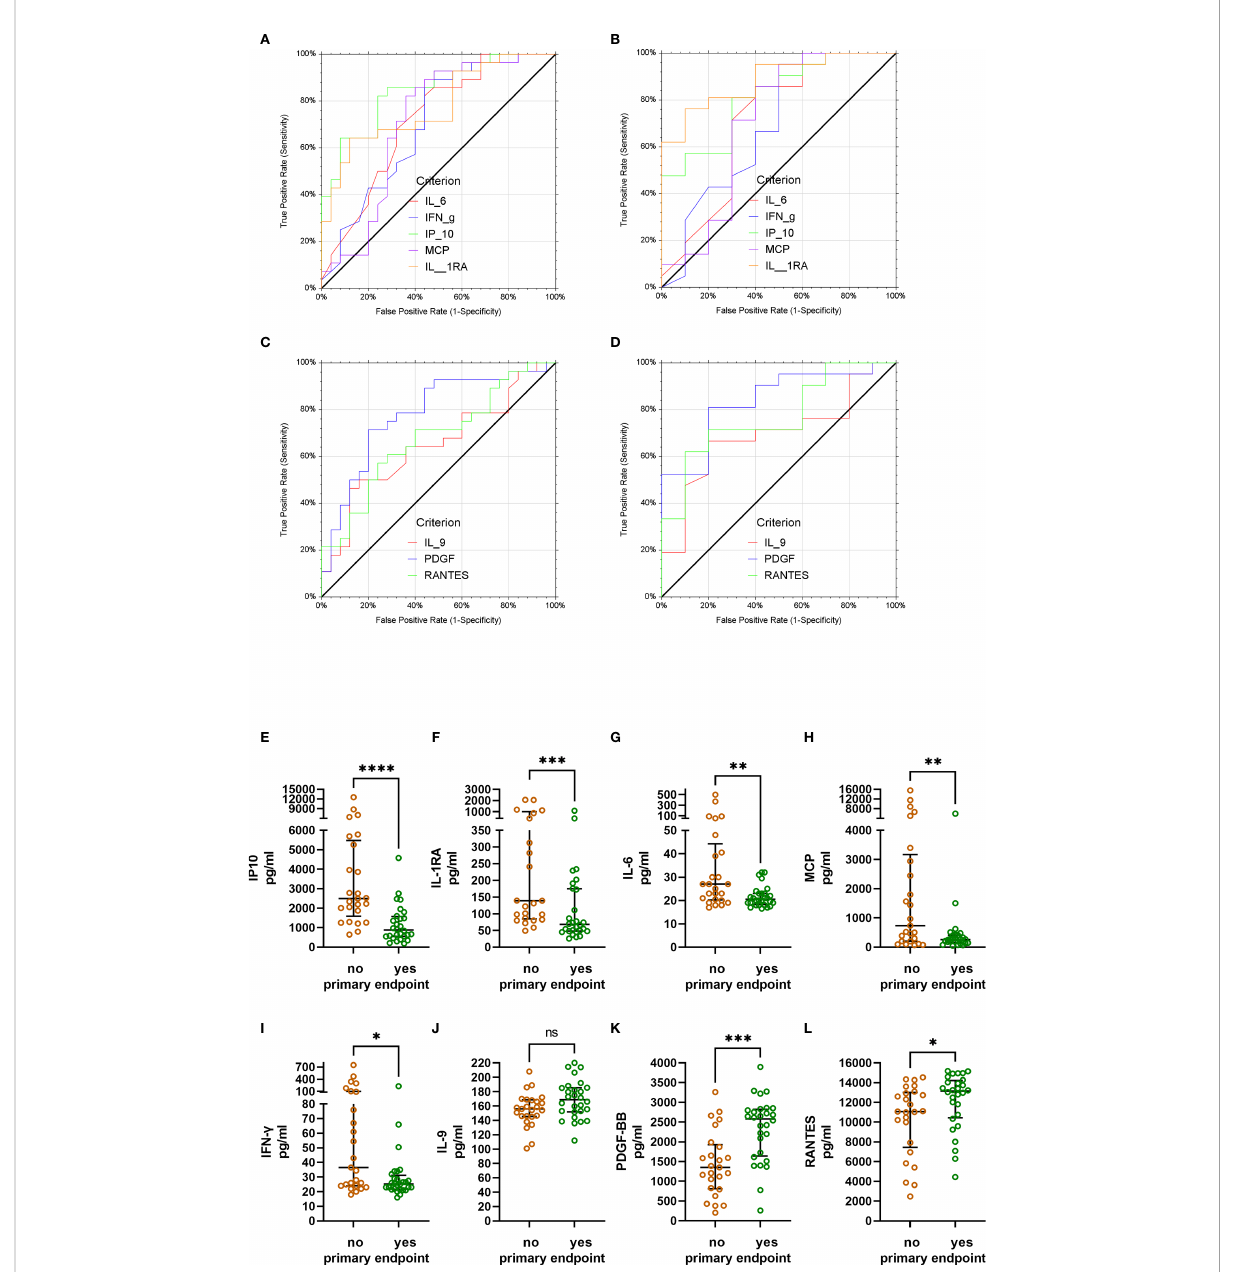
FIGURE 6 Receiver operating characteristics analysis of day 7 cytokine levels and primary endpoint (failure vs. success on day 21). (A) All patients (irrespective of allocation to randomization group). Low levels of IP-10, IL-1RA, MCP-1, IL-6 and IFN- g on day 7 indicate treatment success. Area under the curve (AUC) and p-values for AUC >0.5 were as follows: IP-10: AUC 0.85; p<0.0001; IL-1RA: AUC 0.78, p<0.0001; IL-6: AUC 0.72, p=0.0012; MCP-1: AUC 0.71, p=0.0033; IFN- g : AUC 0.70, p=0.0038). (B) Patients in the CCP group. Low levels of IP-10, IL-1RA, MCP-1 and IL-6 on day 7 indicate treatment success. AUC and p-values for AUC >0.5 were as follows: IP-10: AUC 0.82; p<0.0001; IL-1RA: AUC 0.89, p<0.0001; IL-6: AUC 0.71, p=0.0345; MCP-1: AUC 0.70, p=0.0499; IFN- g : AUC 0.69, p=0.0516). (C) All patients (irrespective of allocation to randomization group). High levels of PDGF-BB, RANTES and IL-9 on day 7 indicate treatment success. AUC and p-values for AUC >0.5 were as follows: PDGF- BB: AUC 0.78; p<0.0001; RANTES: AUC 0.68, p=0.0080; IL-9: AUC 0.65, p=0.0260). (D) Patients in the CCP group. High levels of PDGF-BB, RANTES and IL-9 on day 7 indicate treatment success. AUC and p-values for AUC >0.5 were as follows: PDGF-BB: AUC 0.84; p<0.0001; RANTES: AUC 0.77, p=0.0012; IL-9: AUC 0.69, p=0.0279). (E-L) Bivariate comparison of day 7 levels of IP-10, IL-1RA, IL-6, MCP-1, IFN- g , IL-9, PDGF-BB and RANTES between the patients not reaching the primary endpoint (brown symbols) or reaching the primary endpoint on day 21 (green symbols). Groups were compared by Mann-Whitney test. *p<0.05, **p<0.01, ***p<0.001, ****p<0.0001. ns, not signi fi